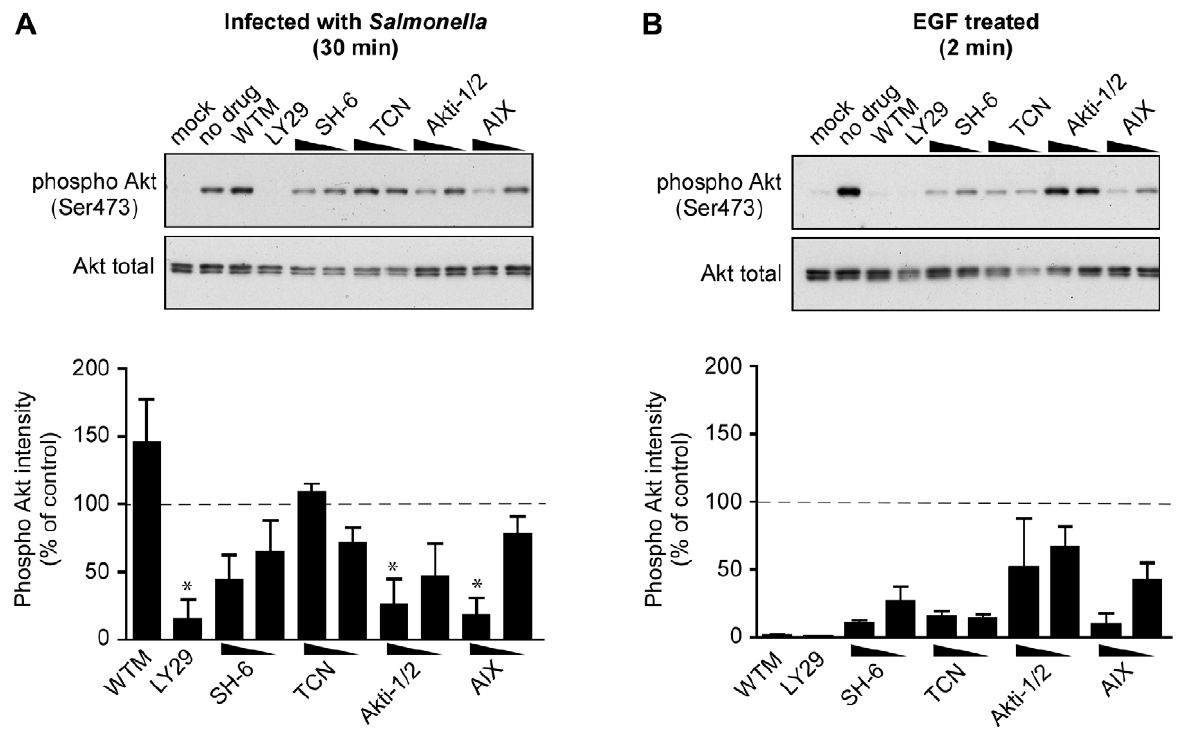
Figure 3. PI3K/Akt inhibitors differentially affect Salmonella -induced and EGF-induced Akt phosphorylation in epithelial cells. HeLa cells were pretreated with PI3K/Akt inhibitors for 30 min and then infected with Salmonella for 30 min (A) or treated with EGF (50 ng/ml) for 2 min (B). Monolayers were then solubilized in sample buffer and processed for immunoblotting using antibodies to detect phospho Akt (Ser473) and total Akt. Inhibitors used were; Wortmanin (WTM:100 nM), LY294002 (LY29: 50 m M), SH-6 (20 m M, 10 m M), TCN (20 m M, 10 m M), Akti-1/2 (0.1 m M, 0.05 m M) and AIX (10 m M, 5 m M). The graphs below each panel show the quantification of Akt phosphorylation estimated by densitometry. Shown are the means 6 SD from three independent experiments (* P , 0.05, significantly different from